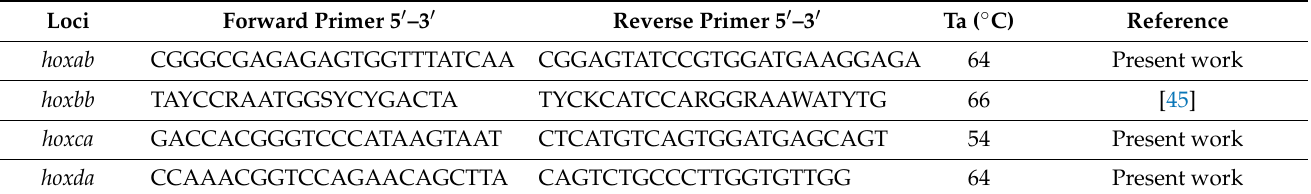
Table 1. Primers used to isolate the hox gene